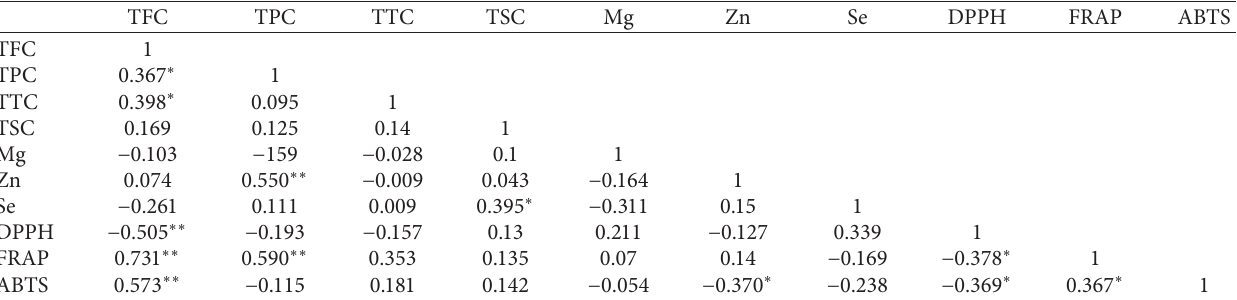
Table 3: Pearson’s correlations among 10 studied traits of C. capsularis and C. olitorius . (considered variables: TFC, TPC, TTC, TSC, Mg, Zn, Se, DPPH, ABTS, and